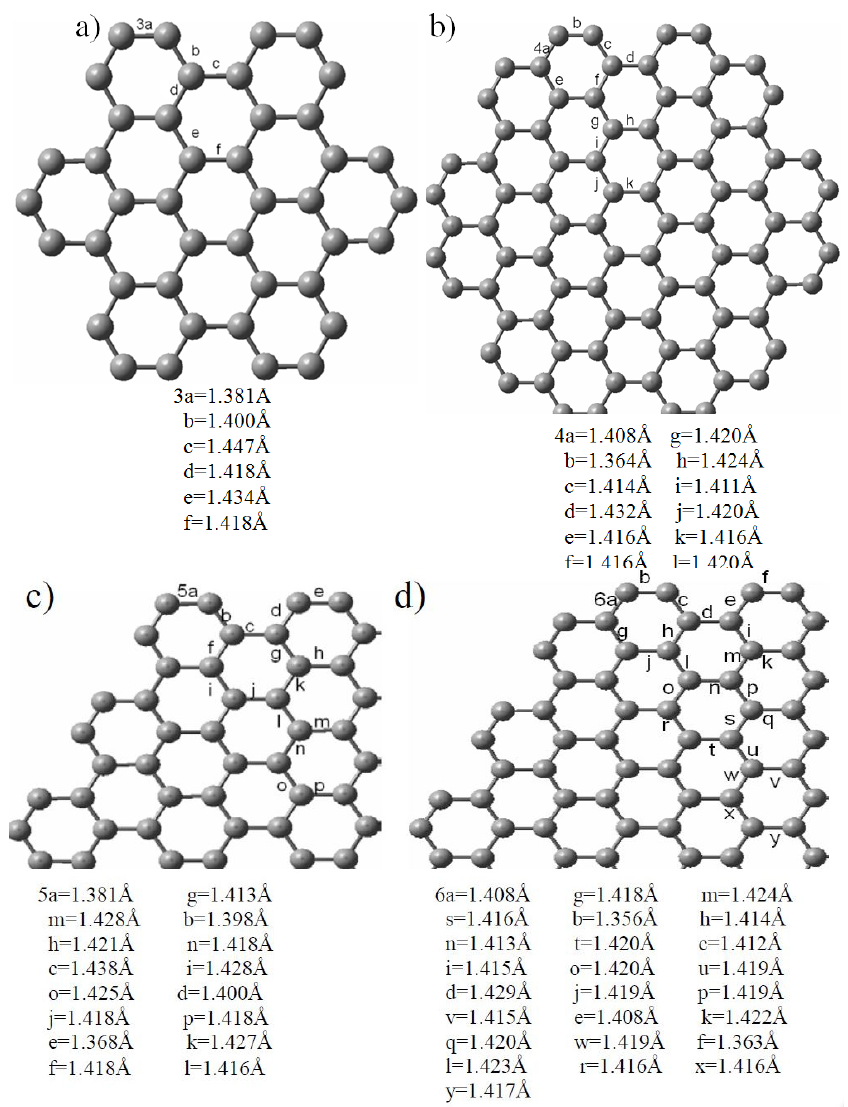
Figure 4. Structures of ( a ) 3-A-HGNS ( b ) 4-A-HGNS ( c ) 5-A-HGNS ( d ) 6-A-HGNS optimized by the PBE/GGA/SIESTA